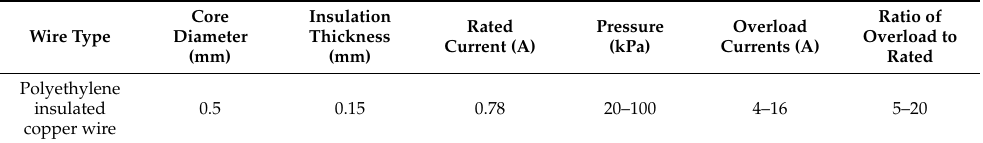
Table 1. Varied pressures via increasing the overload currents.